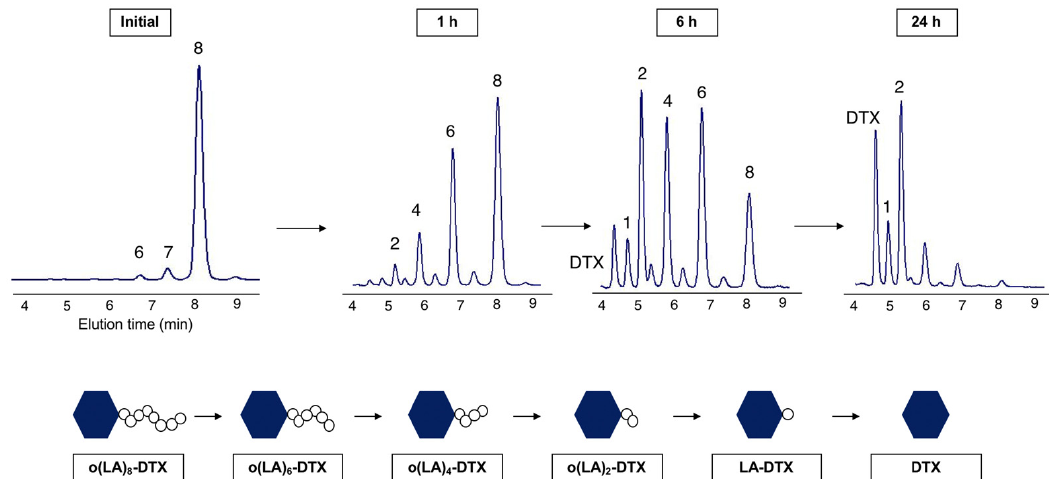
Figure 3. Representative RP-HPLC chromatograms of intramolecular backbiting of o(LA) 8 -DTX in 1:1 ACN:PBS. Numbered peak labels refer to o(LA) n chain length. The elution time of o(LA) 8 -DTX is 8.1 min. As backbiting begins, shorter, even-numbered o(LA) n chain length species with shorter elution times are formed, and DTX is gradually produced over time.